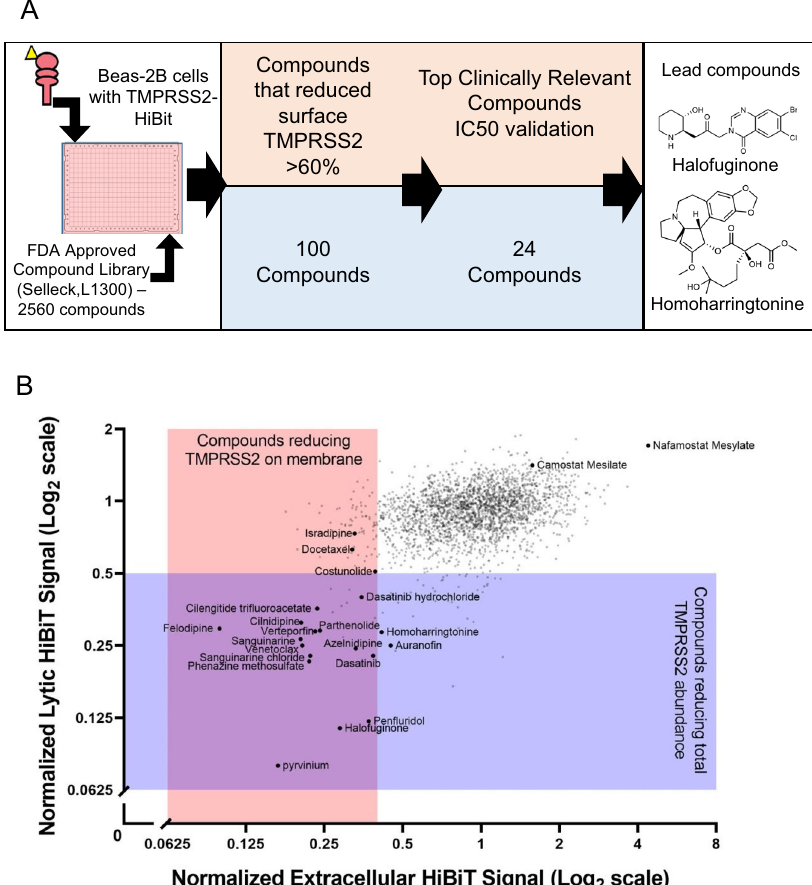
Fig. 2 Screening of airway cells with a FDA-approved or clinically active compound library for agents that reduce TMPRSS2-HiBiT levels. A Screening Assay work fl ow. Initial screening results yielded 100 compounds that decreased surface TMPRSS2 levels (by extracellular HiBiT detection) by 60%. From this, 24 compounds were selected for their clinical relevance and therapeutic potential and validated by IC50 assays. Of these, the most potent hits were halofuginone and homoharringtonine. B Scatterplot of hit compounds from both extracellular HiBiT and lytic HiBiT detection screens. Compounds that reduce membrane TMPRSS2-HiBiT signal (non-lytic extracellular HiBiT detection) are shown in pink, compounds that reduce total TMPRSS2-HiBiT signal (lytic HiBiT detection) are shown in purple. Some individual compounds are speci fi